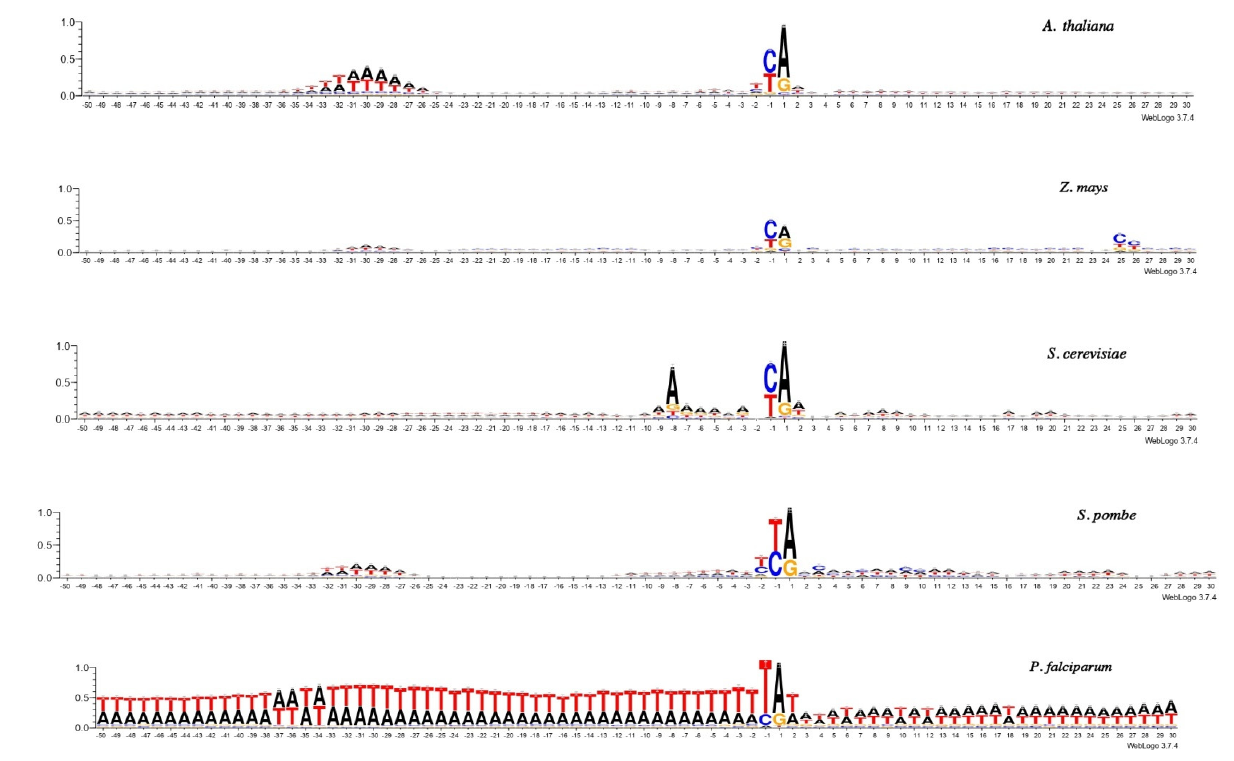
Figure 2. Logo representation with information content 1.0 bits of the promoter sequences of all 15 organisms.